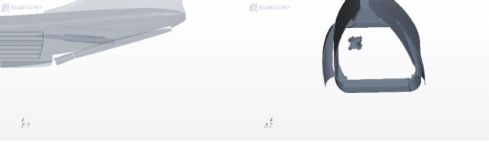
Figure 25: Missile movement posture at 0s.